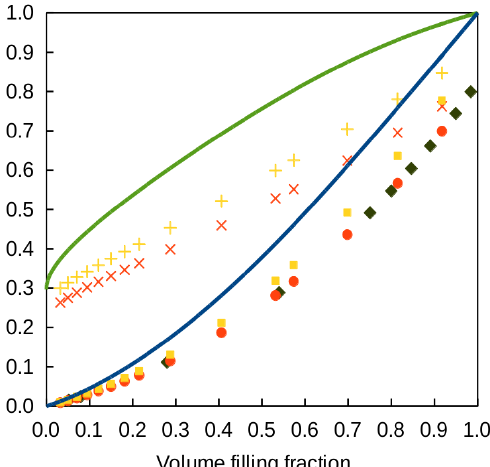
Figure 5. Thermal properties of the Gibson–Ashby lattice model versus filling fraction when the conductivity of air is neglected. Blue curves and green curves: relative conductivity κ e / κ m and thermal conductivity efficiency χ predicted by Equation (10), respectively; yellow squares and red circles: results of full numerical calculations for the layer of Figure 4a,b, respectively; yellow and red crosses: corresponding thermal conductivity efficiencies χ ; blue diamonds: relative conductivity obtained numerically by other authors (see text).